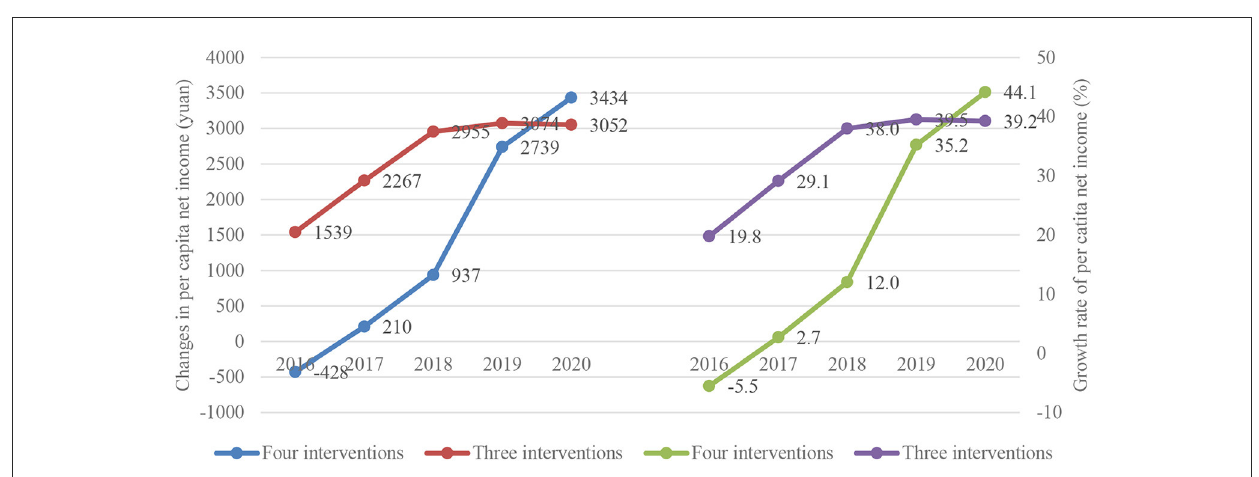
FIGURE1 Yearly changes in per capita net income of rural residents (left) and its growth rate (right) in counties with all four measures and countries with three measures.